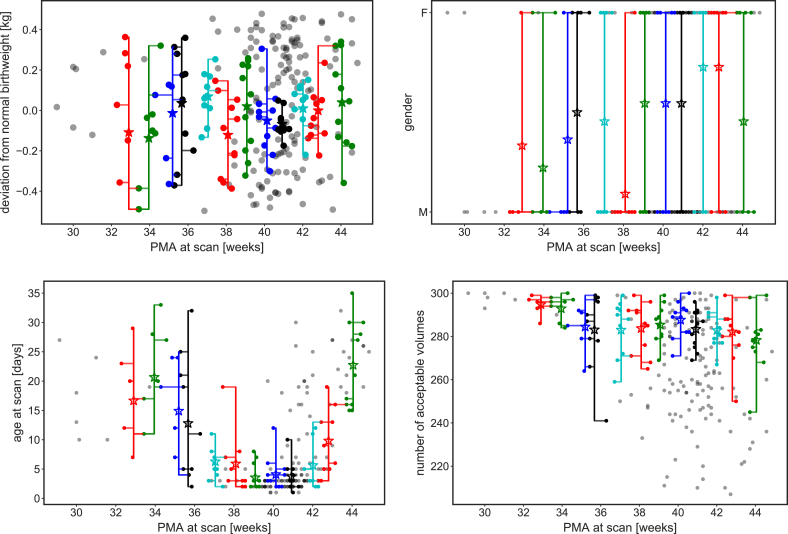
Demographics of the cohort. Lines link subjects that were grouped to build the weekly templates. Asterisks indicate the average for each template. Subjects that are part of the dHCP but were not used for this work are shown as grey dots.